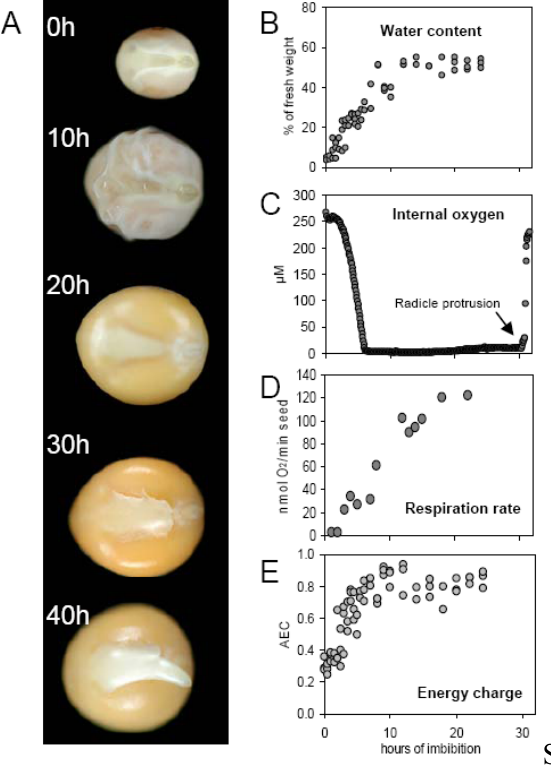
Figure 3. Morphological and biochemical changes during imbibition of seeds of pea (Pisum sativum L., var Baccara). (A) Visual changes of dry seeds (0 h) with swelling of seed coat (after 10 hours) and cotyledons (20 h), radicle protrusion breaking the seed coat (30 h) and radicle outgrowth (40 h). Concomitant changes were monitored for water content of the embryo (B), internal oxygen concentration (C), respiration rate (D), and adenylate energy charge (E). Data in (B-E) are taken from